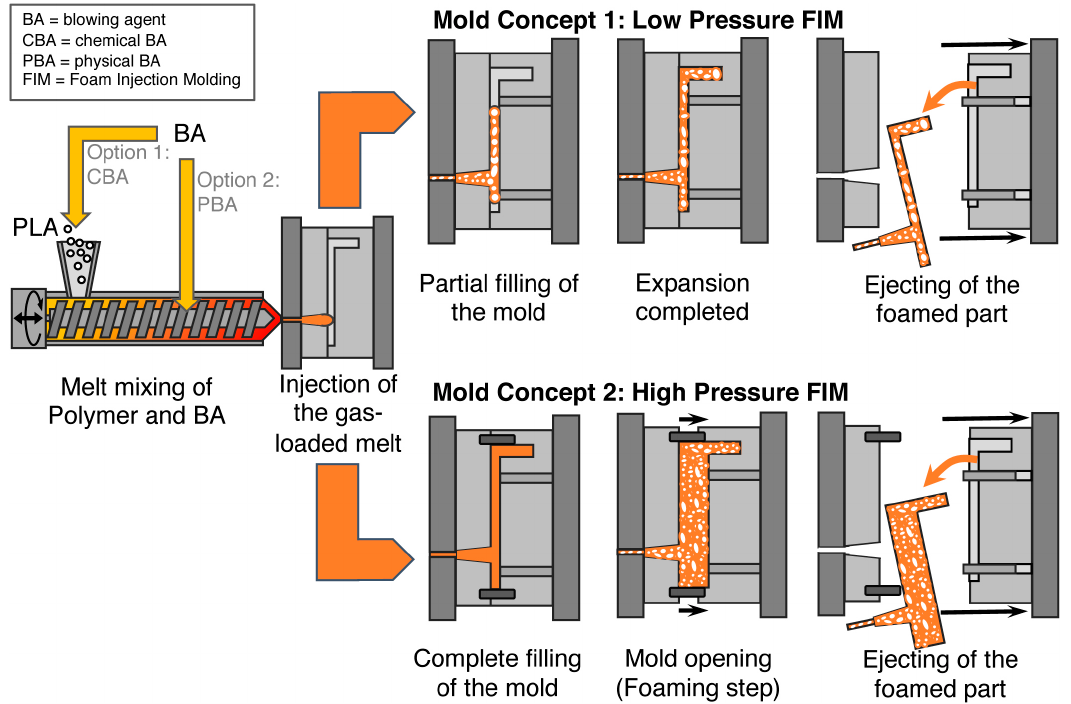
Figure 6. Principle of foam injection molding with the two optional mold concepts.